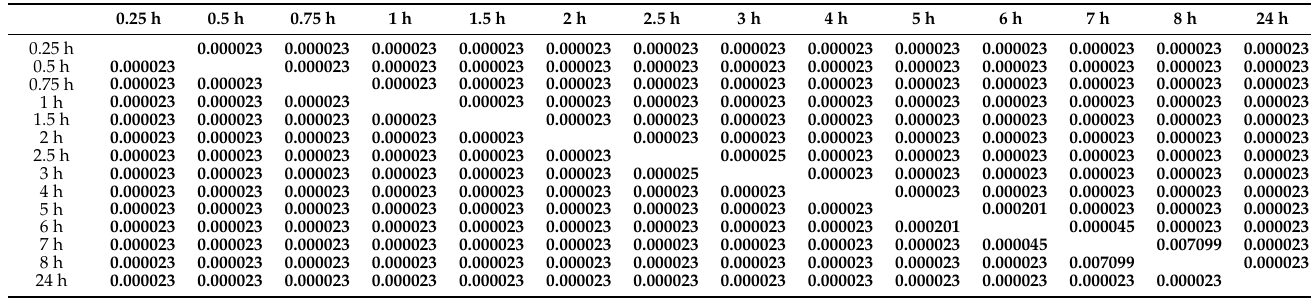
Table A8. Significant differences for the EMC variable for the effect of climatic chamber operation time (CCOT) according to Tukey’s test (HSD) for butternut-squash